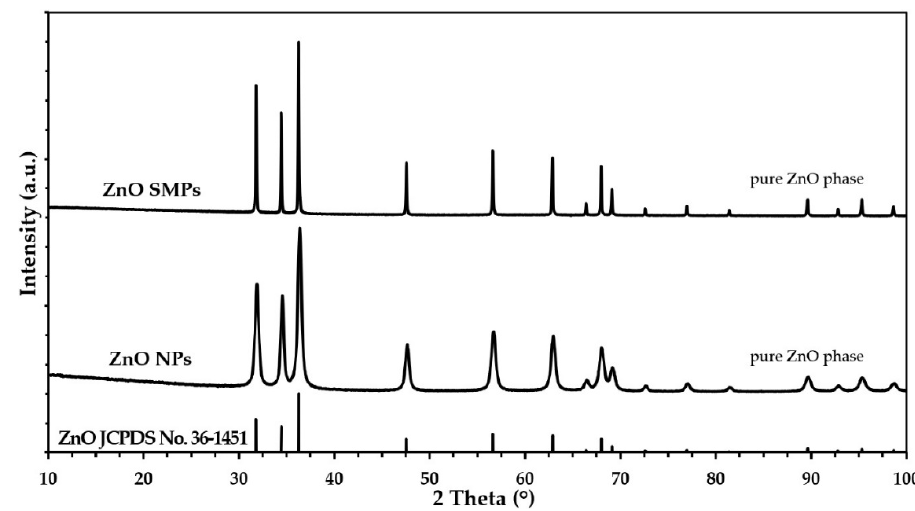
Figure 2. The X-ray powder di ff raction (XRD) patterns for ZnO NPs and ZnO SMPs.